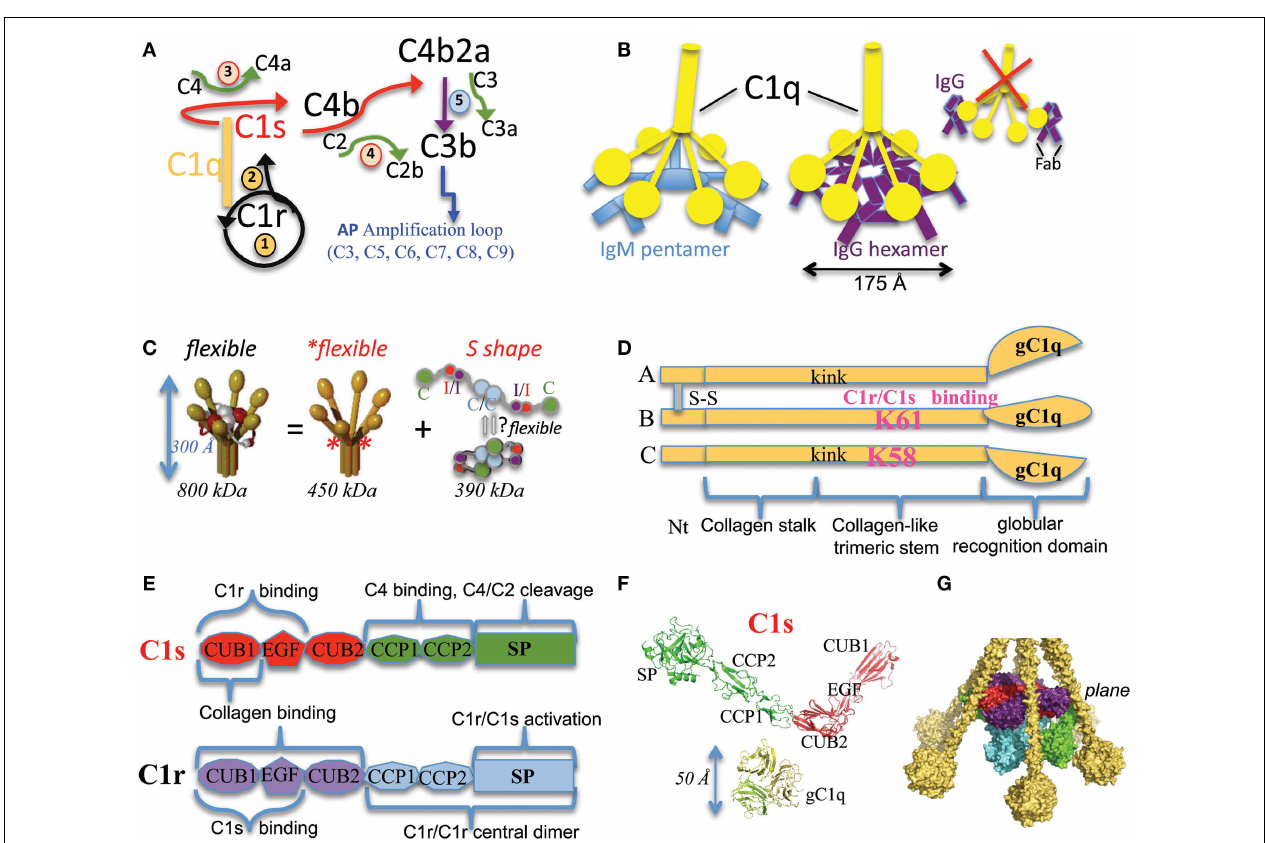
tetramer conformational equilibrium on the right are derived from (3). (D) Modular structure of each C1q chain type. A, B and C chains associate as a hexamer of ABC heterotrimers. Kink indicates the position of disruptions in the triplets occurring only within collagen-like sequences of the A and C chains and probably inducing flexible hinges.The disulfide bridging between chains A and B is illustrated.The C chain has no covalent link with A and B chains, but covalently associates pairs of ABC trimers through a C–C disulfide bridge.The two lysines crucial for C1 assembly are shown in pink. (E) Modular structure and associated functions of C1r and C1s.The catalytic domain includes the C-terminal serine protease (SP) domain as well as the preceding Complement Control Protein (CCP or sushi) modules.The interaction domains of C1s and C1r involve their N-terminal CUB–EGF–CUB modules.The corresponding functional implications are mentioned.The same color coding is used in (F,G) and in the right panel of (C) . “CUB” means initially found in Complement C1r and C1s, Uegf and BMP-1. (F) C1 is a large complex made of small building blocks of (mainly) known structures.The displayed C1s is a composite structure obtained after superposing the PDB structures 1ELV (4) and 4LMFA (5) onto 4LOT (5) (see details inTable S1 in Supplementary Material).The color code used is the same as in (C,E) .The chains ABC from the C1q globular domain [2WNV (6)] are shown on the same scale. (G) Example side view of a partial composite C1 model, refined using the results of differential accessibility in C1q and C1 using chemical lysine labeling followed by mass spectrometry (7).The C1r and C1s proteases interact with C1q through their interaction domains aligned on the same plane (which corresponds to the position of LysB61 and LysC58 in C1q).This part of the model is mainly confirmed by recent complementary experimental studies (8).The position of the catalytic domain of C1s is more uncertain and probably